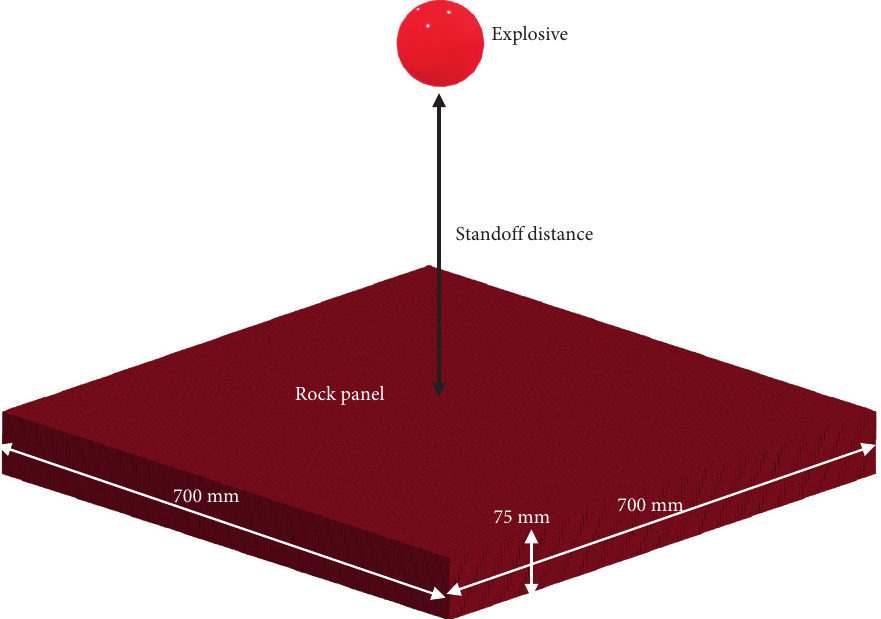
Figure 3: Numerical model setup of rock panel subjected to blast